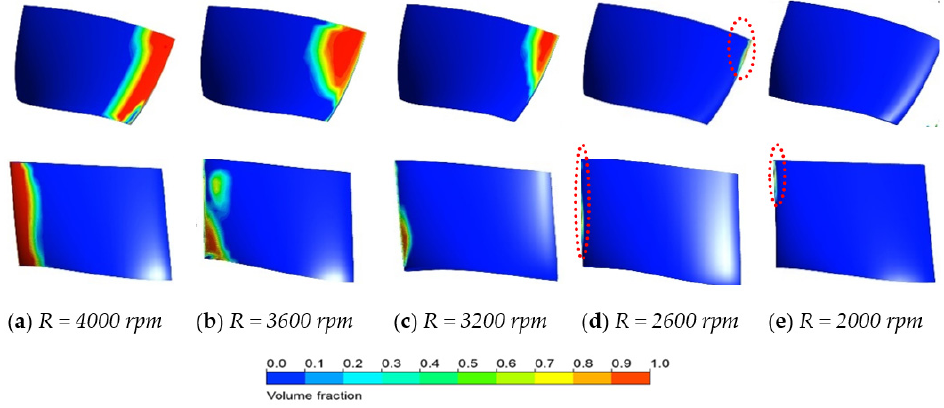
Figure 13. Water vapor volume fraction cloud of the rotor and stator blades.